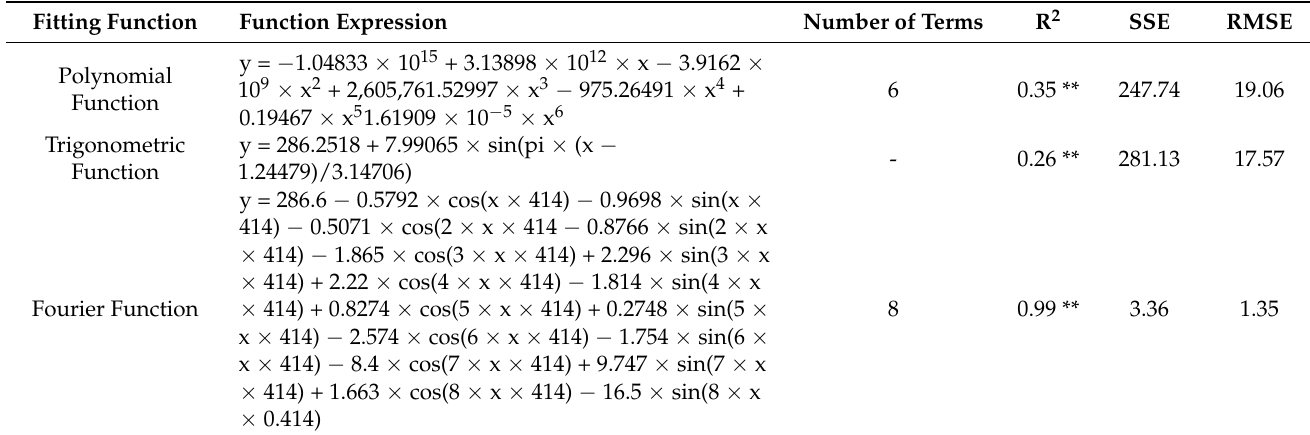
Table 4. The accuracy analysis of the results by different fitting functions.